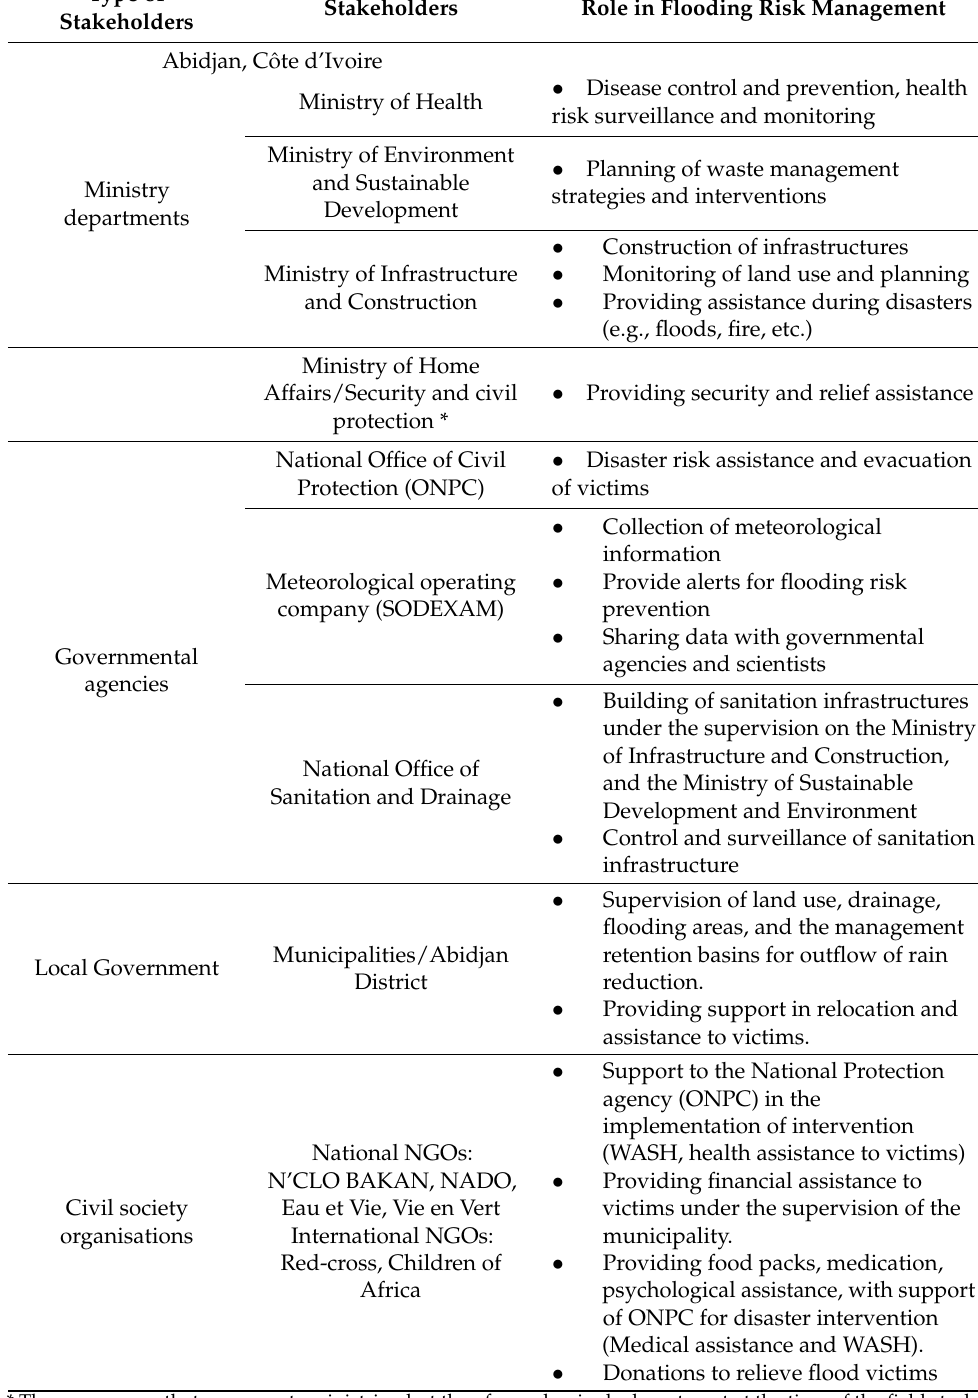
Table 1. Stakeholders and implication in flooding risk management in